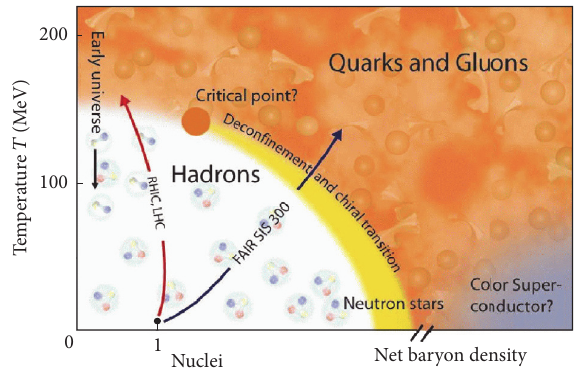
Figure 1: Schematic phase diagram of the QCD matter. The net baryon density on 𝑥 -axis is normalized to that of the normal nuclear matter